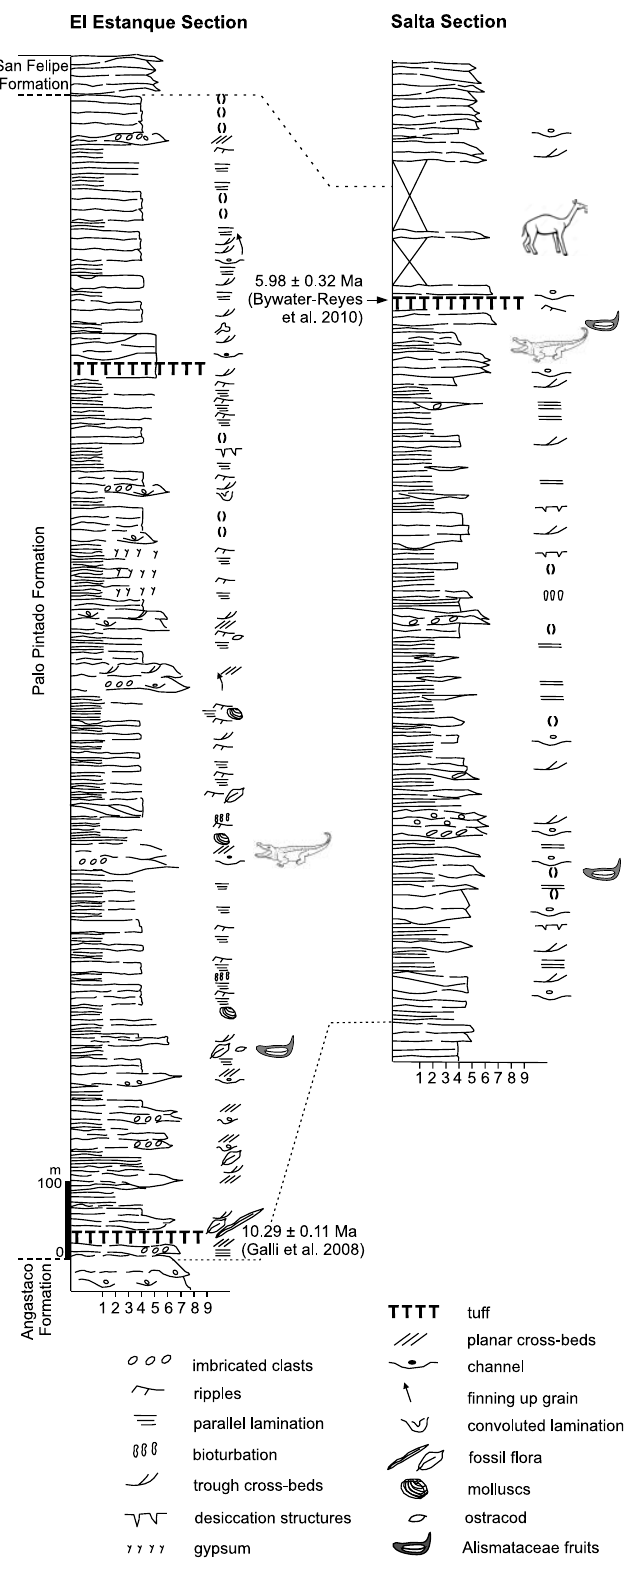
Fig. 2. Stratigraphic correlation of the Quebrada Salta and Quebrada El Estanque localities (Palo Pintado Formation, upper Miocene). 1, clay; 2, limolite; 3, fine sandstone; 4, middle sandstone; 5, coarse sandstone; 6, fine conglomerate; 7, middle conglomerate; 8, coarse conglomerate; 9,